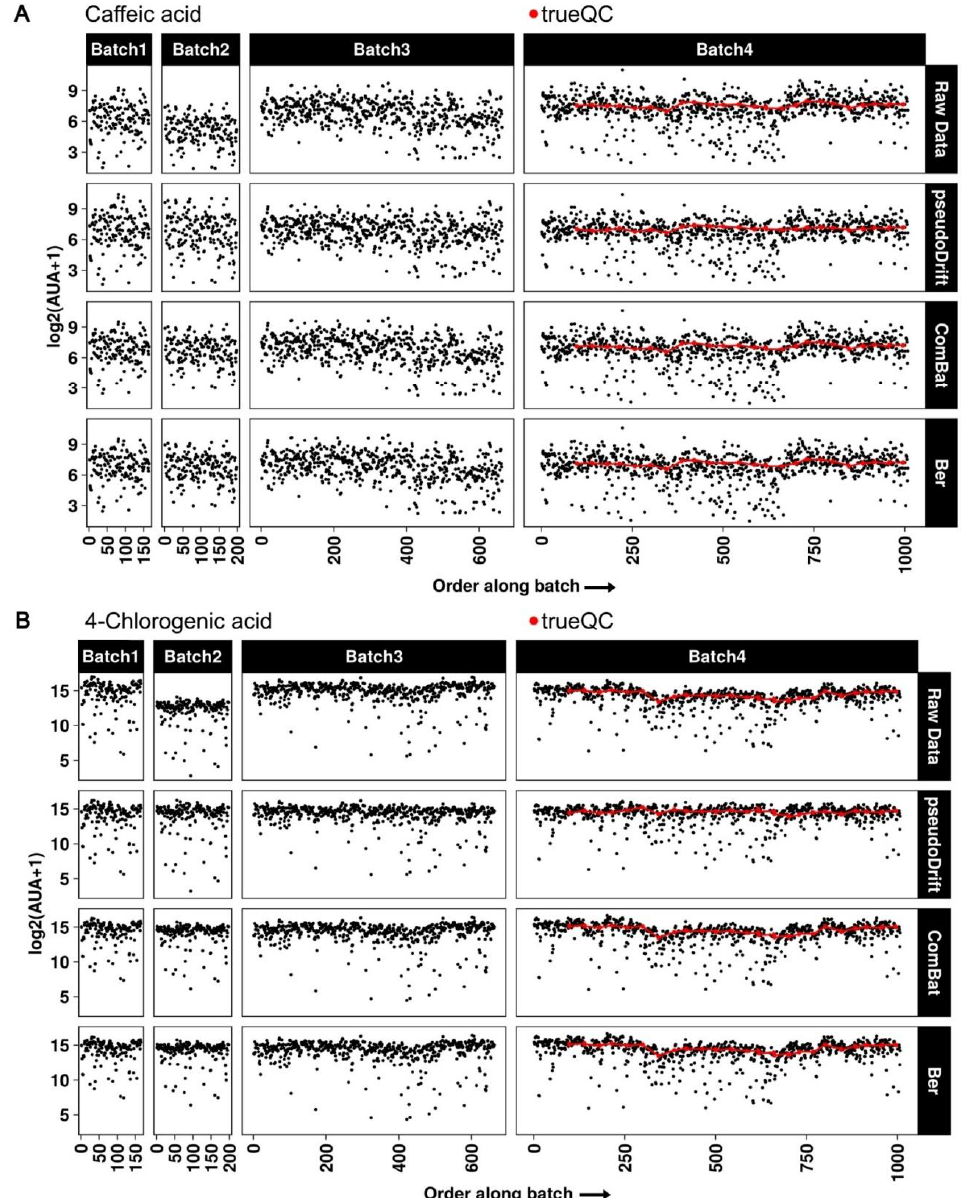
Figure 5. Batch-to-batch and intra-batch signal drift effects before and after correction with different non-QC-based corrections. Plotted are the log2 transformed arbitrary units of area (AUA) for caffeic acid ( A ) and 4-chlorogenic acid ( B ) before correction (raw data) and after correction with each labeled